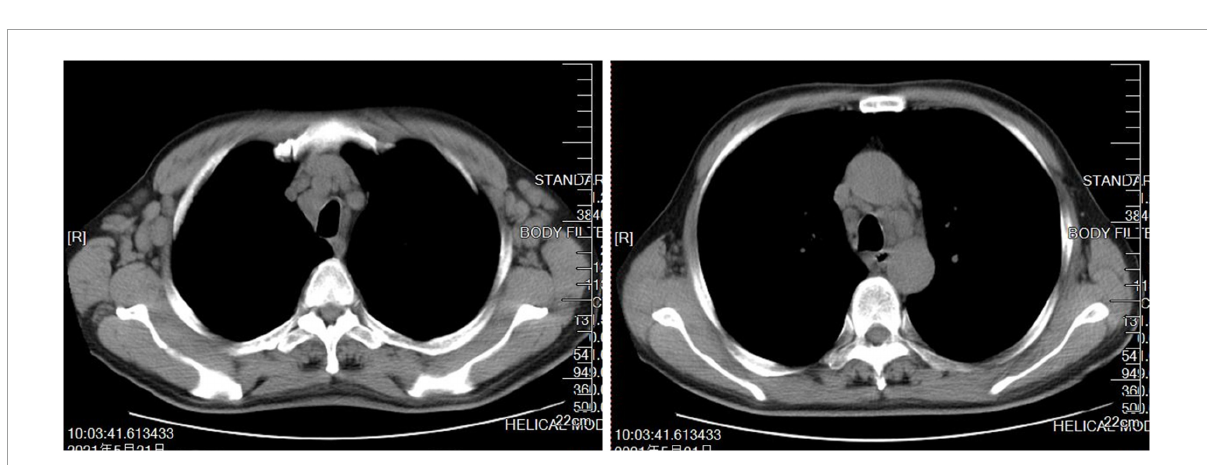
FIGURE2 Mediastinal window of patient’s initial computed tomography (CT) scan showed multiple enlarged lymph nodes in mediastinum and bilateral axilla.